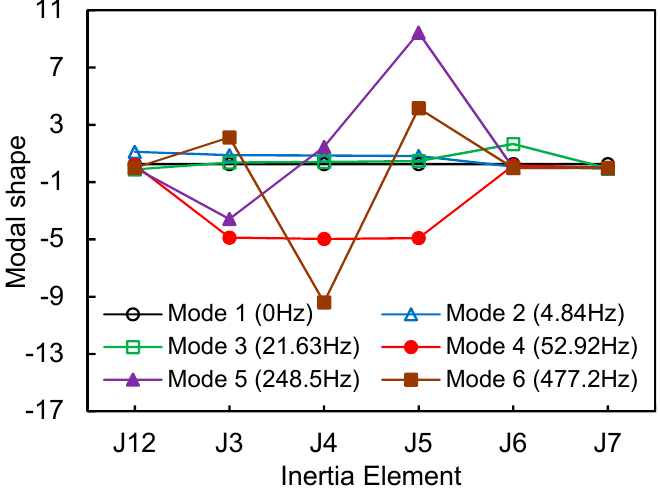
Figure 8. Modes of the driveline system.